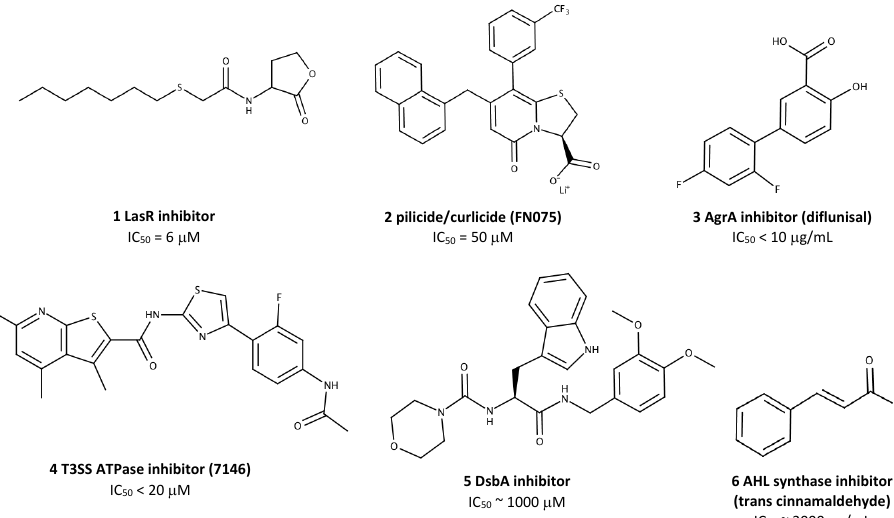
Figure 3. The structures of antivirulence compounds that have been discovered using SBDD techniques. IC 50 , half-maximal inhibitory